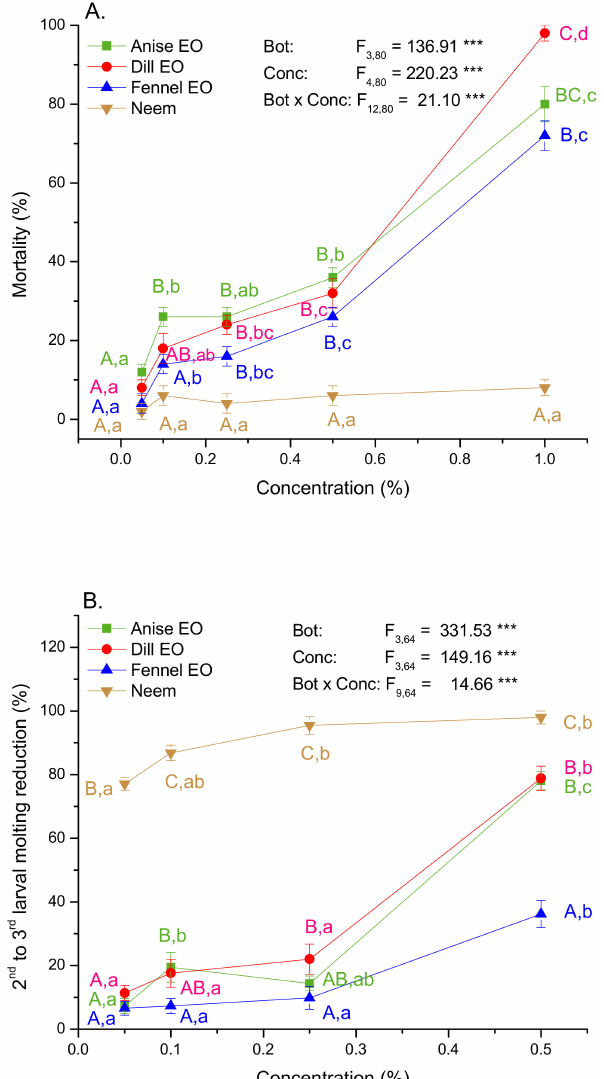
Figure 2. Digestive toxicity in the 2nd instar GML ( A ) and the 2nd to 3rd molting reduction ( B ) (mean ± SE) after 120 h (24 h exposure to EOs or neem supplemented diet followed by 96 h feeding on untreated diet). GML were exposed to different EOs and neem concentrations. F-values were obtained from two-way ANOVA testing significance of the main (botanical type—Bot and concentration—Conc) and interaction (Bot × Conc) effects on analyzed traits (*** p < 0.001). Different colored letters mark significant differences among EOs and neem within each concentration (capital letters A, B, C), and among concentrations within each EO and neem (small letters a, b, c, d) (LSM contrasts, p < 0.05). There was no mortality in GML fed on untreated diet for 120